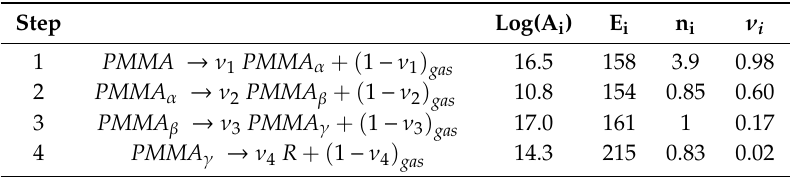
Table 4. Overall steps and apparent kinetic parameters proposed by Fateh et al. considering the multiphase nature of the chemical recycling; fitting based on Equations (13) and (14); R: residue [115]. MMA is formally part of the gas phase